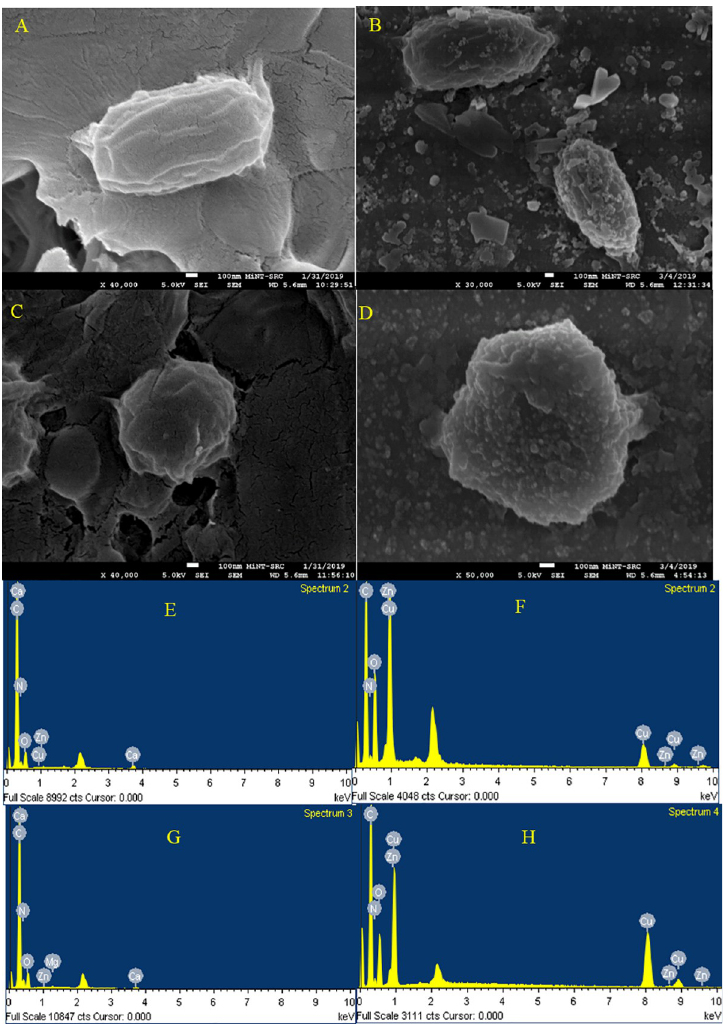
mL -1 of Cu/Zn NPs, at pH 6 and after 60